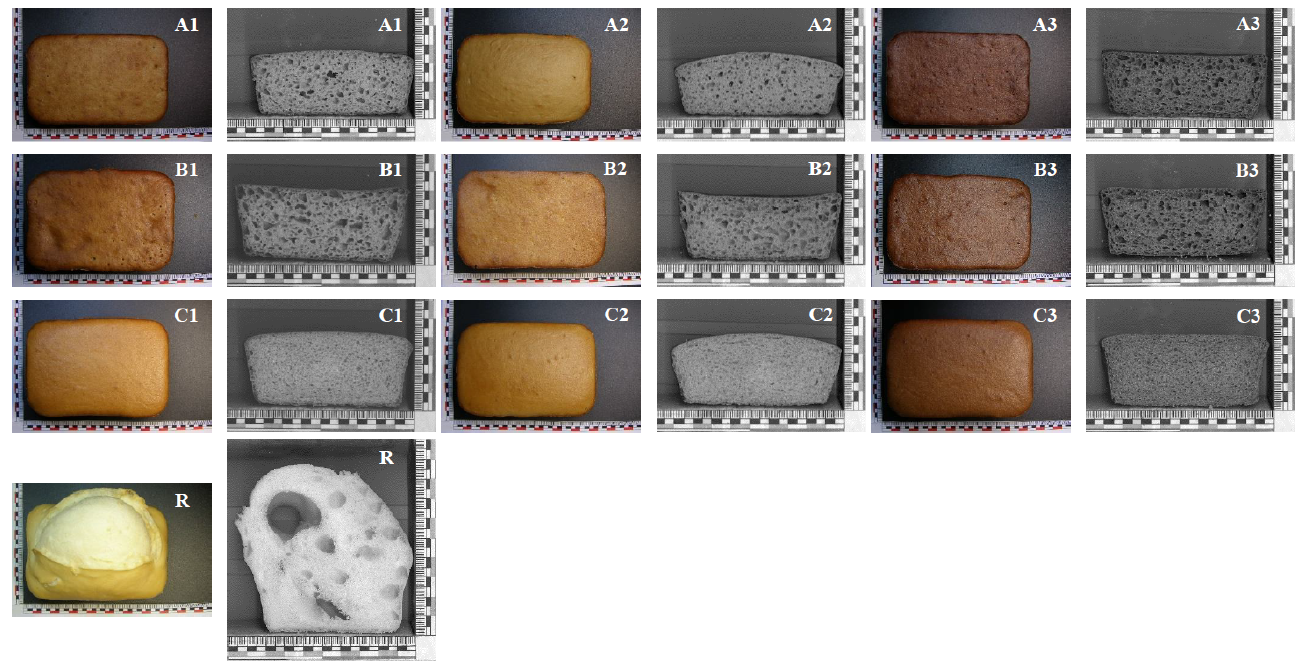
Figure 1. The influence of tef flour incorporation level and variety on the appearance of GF breads. Addition levels: ( A ): 100 g tef flour per 100 g of mixture; ( B ): 75 g tef flour per 100 g of mixture; ( C ): 50 g tef flour per 100 g of mixture; tef varieties: 1: DZ-Cr-37; 2: DZ-Cr-387; 3: DZ-01-99; ( R ): 100 g/100 g maize starch